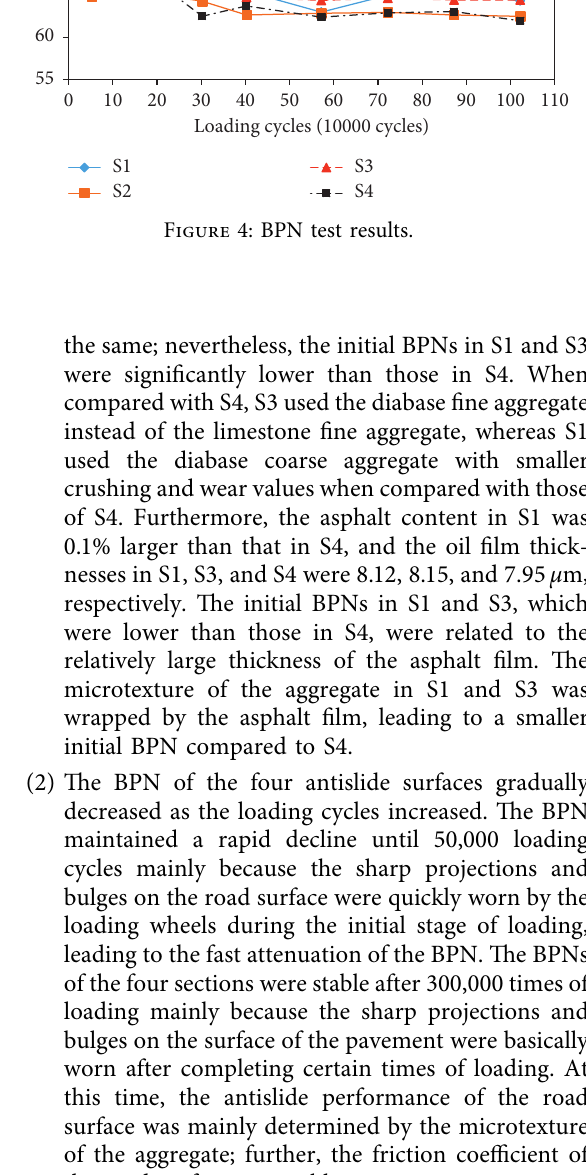
Figure 5 and Table 7 present the following results: